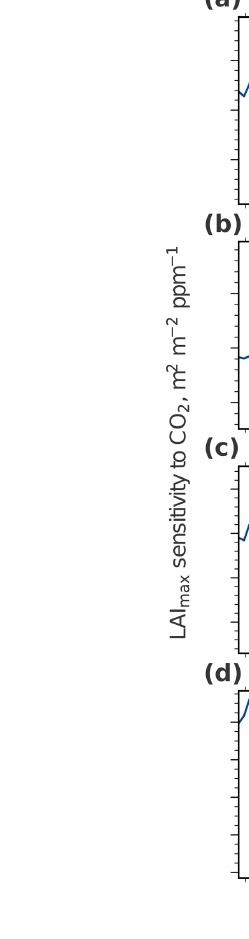
Figure A3. Temporal variation of LAI max sensitivity to ω in four CMIP5 models analogous to Fig. 4. The colored lines show LAI max sensitivity variations for moving windows of varying length: 15 (blue), 30 (green), and 45 (red) years over the historical period from 1860 to